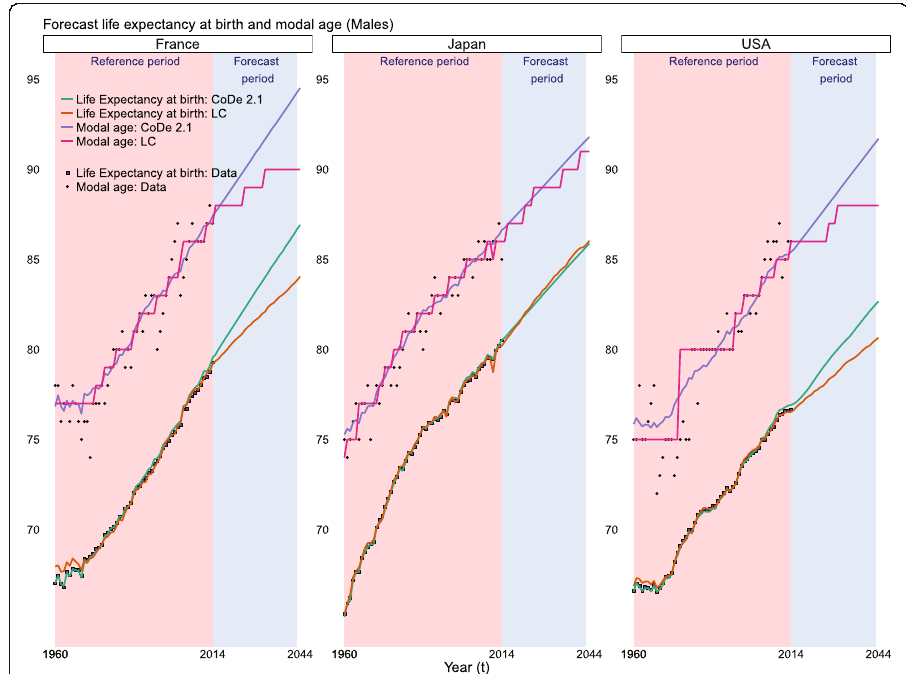
Fig. 10 Estimation and out-of-sample projections of life expectancy at birth and of the modal age of males using the CoDe 2.1 model and the LC model. The reference period is 1960 – 2014 (pink); the projection period is 2015 – 2044 (blue)